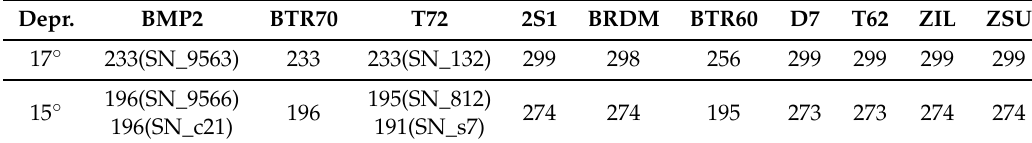
Table 4. The number of images for ten-class targets.